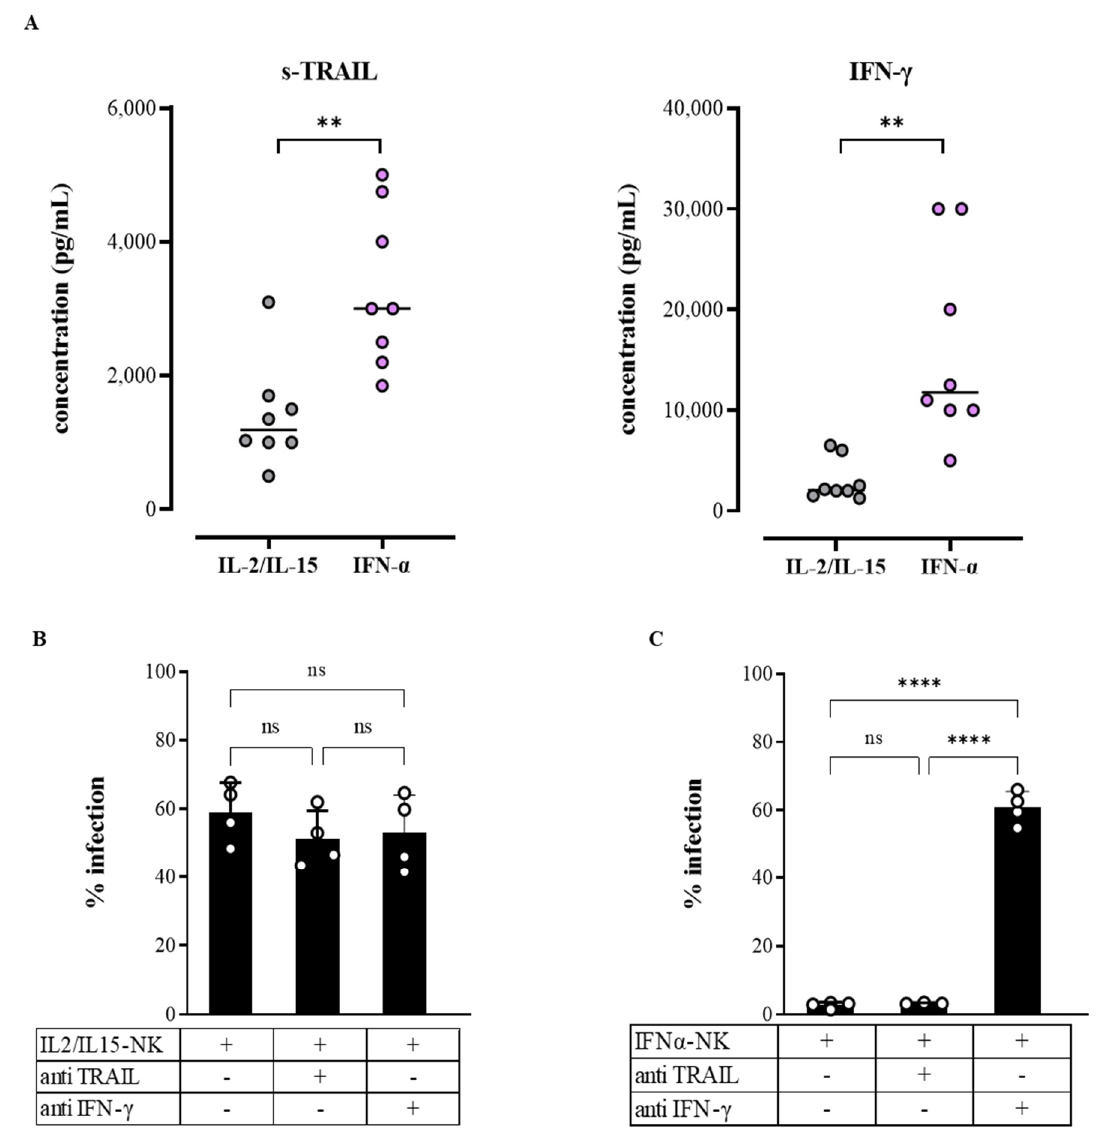
Figure 4. s-TRAIL and IFN- γ were differentially released by IFN α -NKs and IL2/IL15-NKs, but only IFN- γ contributed to the enhanced antiviral functions of IFN α -NKs. ( A ) Dot plots of s-TRAIL and IFN- γ cytokine expression (pg/mL) in the conditioned media of NK cells activated overnight with IL-2/IL-15 (gray) or IFN- α (lilac). Each dot represents a donor ( n = 8). Means are shown. ( B , C ) Infection rates (percentage of control) of HCV-Huh7.5 cells exposed in transwells to either IL2/IL15-NKs ( B ) or IFN α -NKs ( C ). Infection rates were calculated by measuring HCV-Ag levels released in the culture media seven days after co-culture. Where indicated, a blocking anti-TRAIL antibody (10 µ g/mL) or an anti-IFN- γ neutralizing antibody (10 µ g/mL) was added to the culture. Each dot represents the average of three technical replicates from one donor ( n = 4). Mean values ± SEM are shown. Statistical analyses were performed using Student’s t -test ( A ) and the one-way ANOVA with Tukey’s multiple comparisons test. ** p < 0.01, **** p < 0.0001; n.s., non-significant. To investigate whether s-TRAIL and IFN- γ could contribute to the enhanced antiviral functions of IFN α -NKs, we co-cultured HCV-Huh7.5 cells in transwells with either IL2/IL15-NKs or IFN α -NKs and added neutralizing monoclonal antibodies to block the function of s-TRAIL or IFN- γ . As shown in Figure 4B, the neutralization of s-TRAIL did not affect the IL2/IL15-NK or IFN α -NK response, as indicated by unchanged HCV-Ag levels in the media. However, we could appreciate a significant increase in HCV-Huh7.5